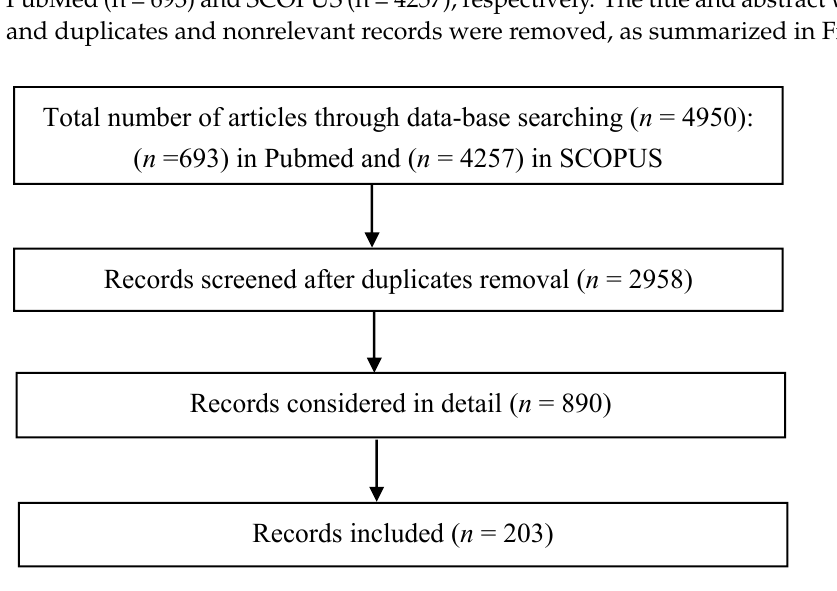
Figure 1. Flow-chart of the study selection